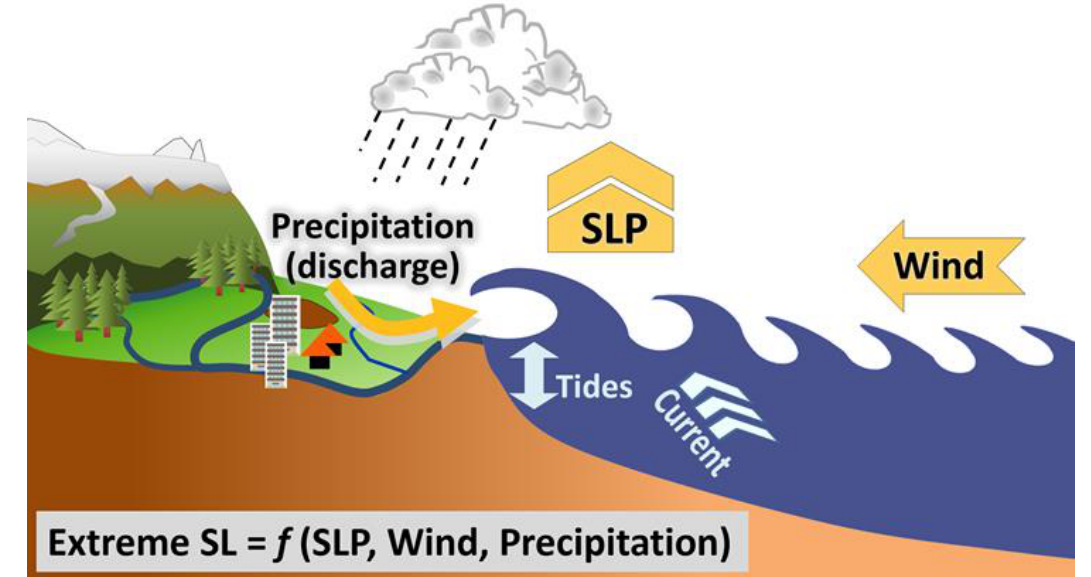
Figure 2. Contributing factors for extreme sea levels. The meteorological factors contributing to the extreme sea level are indicated in orange. SLP represents sea level pressure.